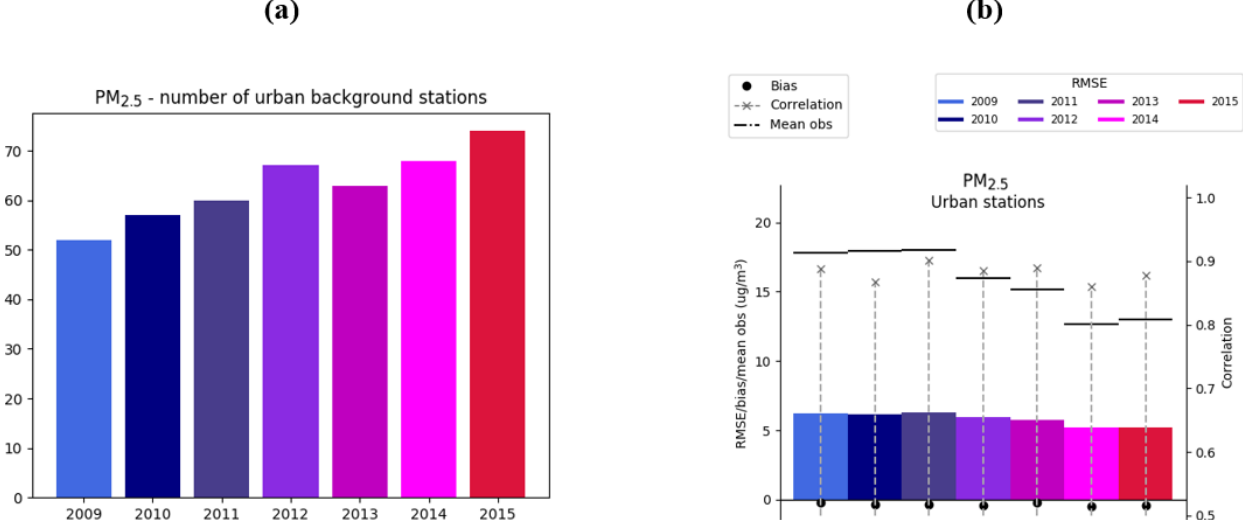
Figure 4. PM 2 . 5 : statistical indicators calculated using cross-validation technique on daily mean PM 2 . 5 values measured and estimated over URBAN background stations for the years 2009 to 2015. (a) Number of rural stations for each year. (b) Bias (black circles), RMSE (colored rectangles), correlation (grey crosses and the associated dashed lines) and mean observation (dotted horizontal